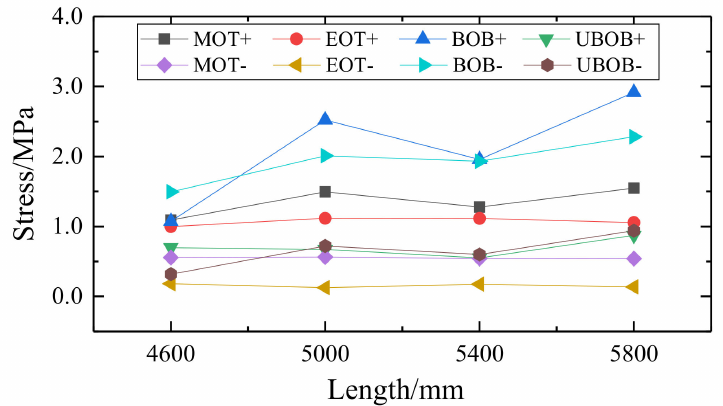
Figure 15. Influence of length on temperature stress of adjustment layer (In legend identification, “+” means positive temperature gradient; “ − ” means negative temperature